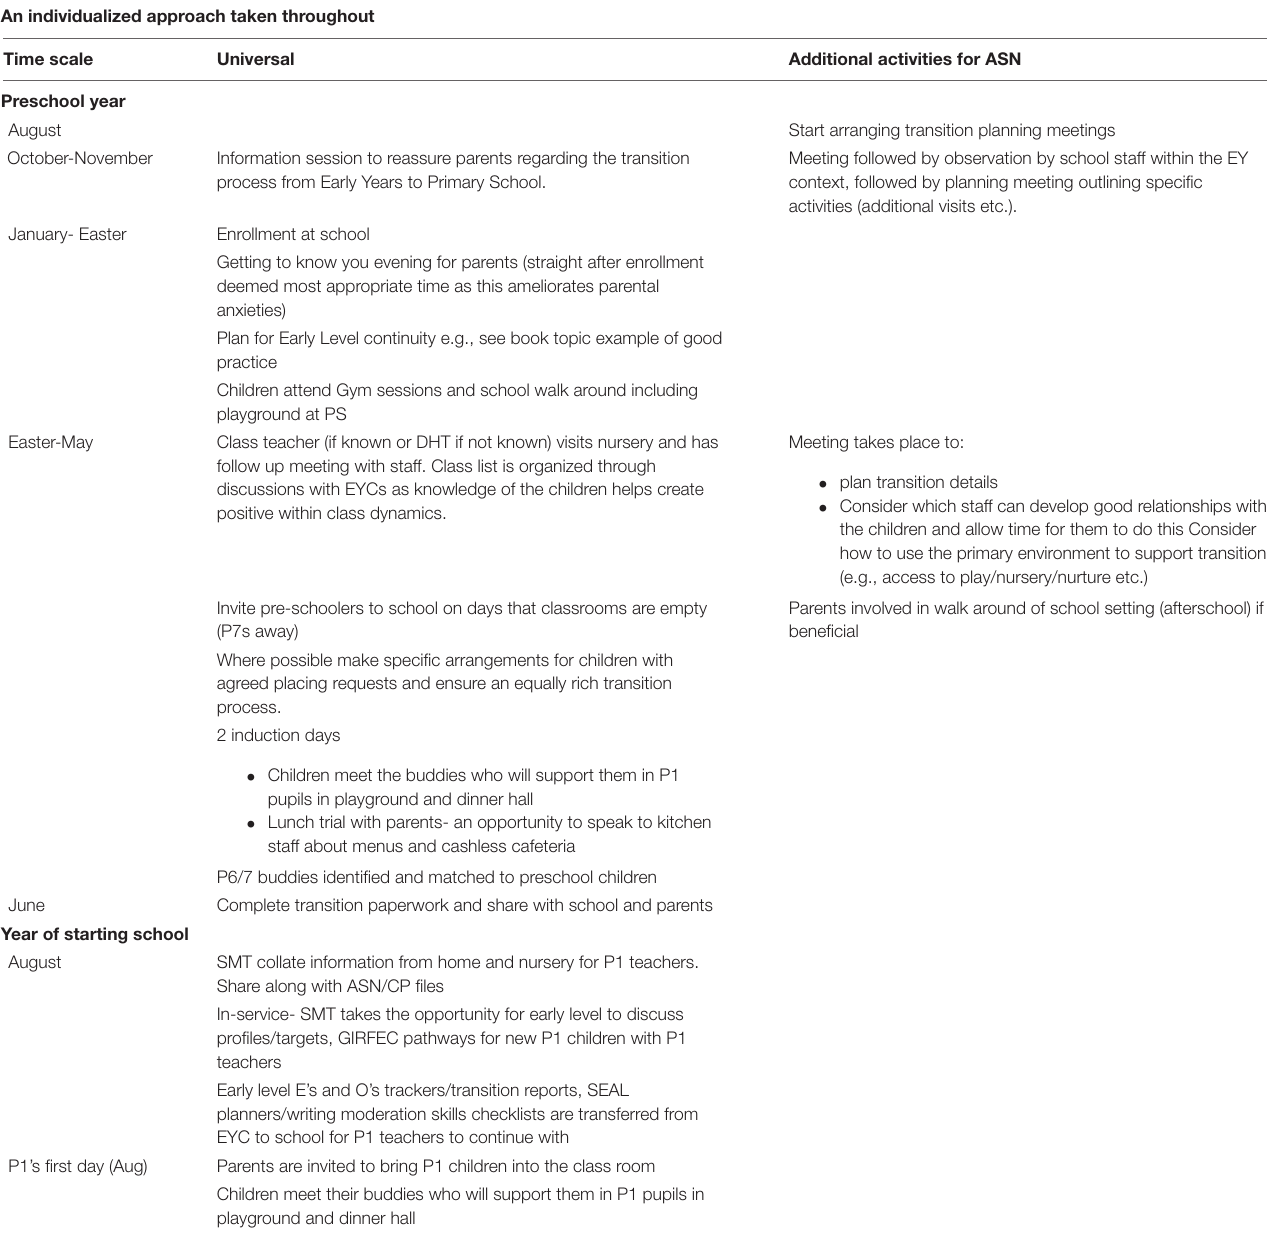
TABLE 2 | Core activities needed for transition from preschool to primary